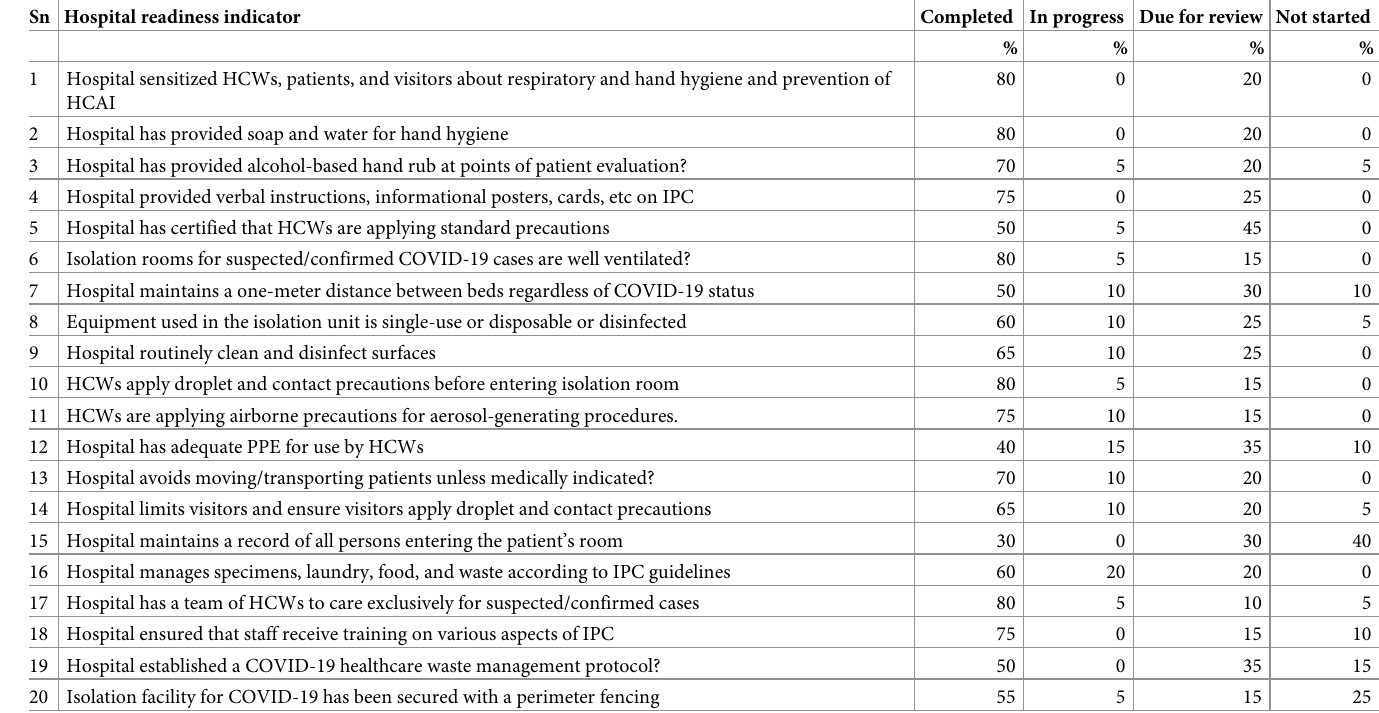
Table 4. Implementation of infection prevention and control readiness indicators among 20 hospitals in